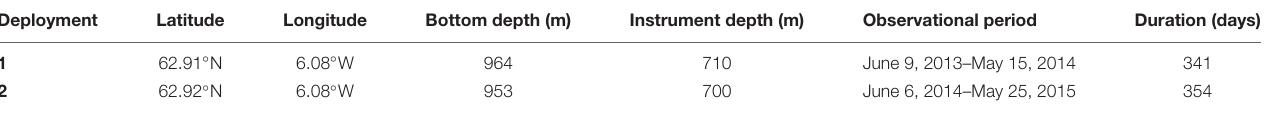
TABLE 1 | ADCP deployments between station N04 and N05 on Section N (see Figure 1 ).